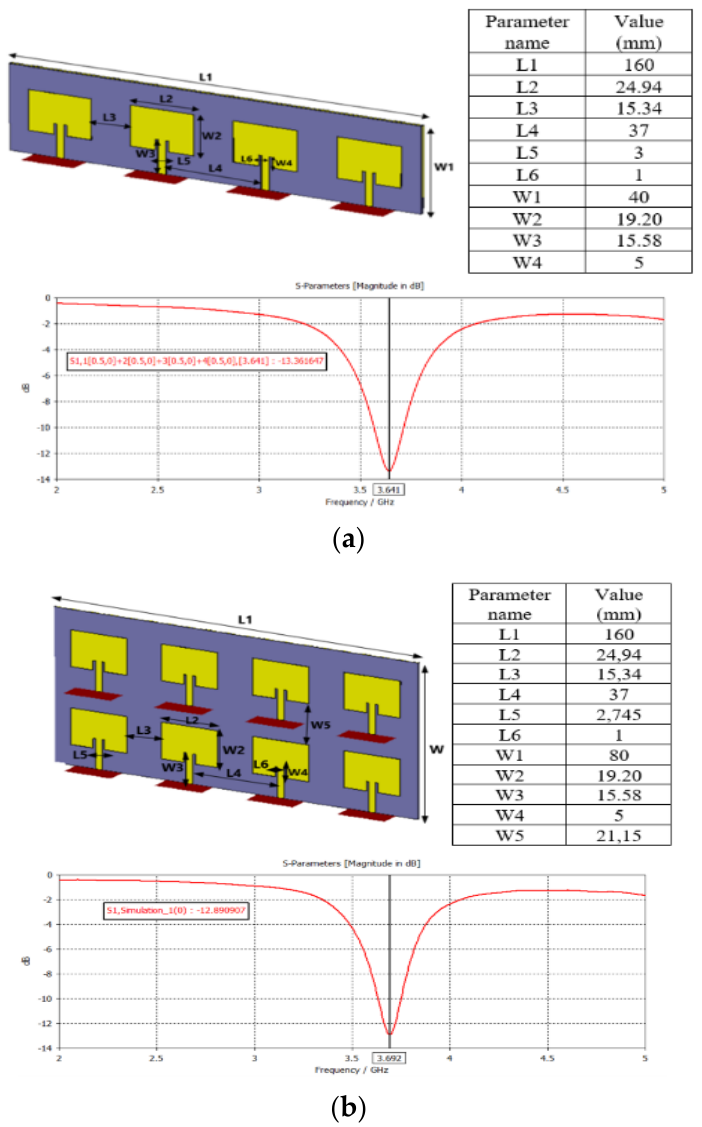
Figure 1. Configuration of the modeled antenna arrays and the computed reflection coefficient (S 11 ) for: ( a ) linear array of 1 × 4 elements and ( b ) planar array of 2 × 4